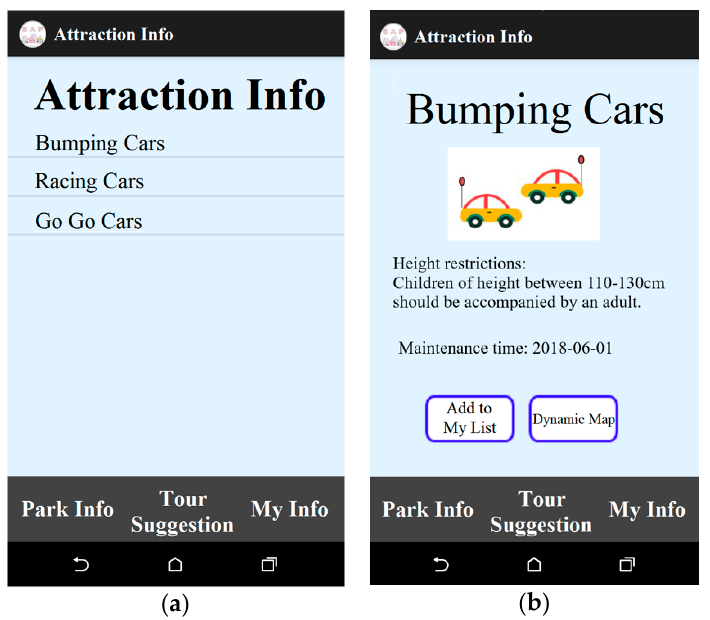
Figure 6. Experimental results of attraction information display: ( a ) attraction list; and ( b ) results.